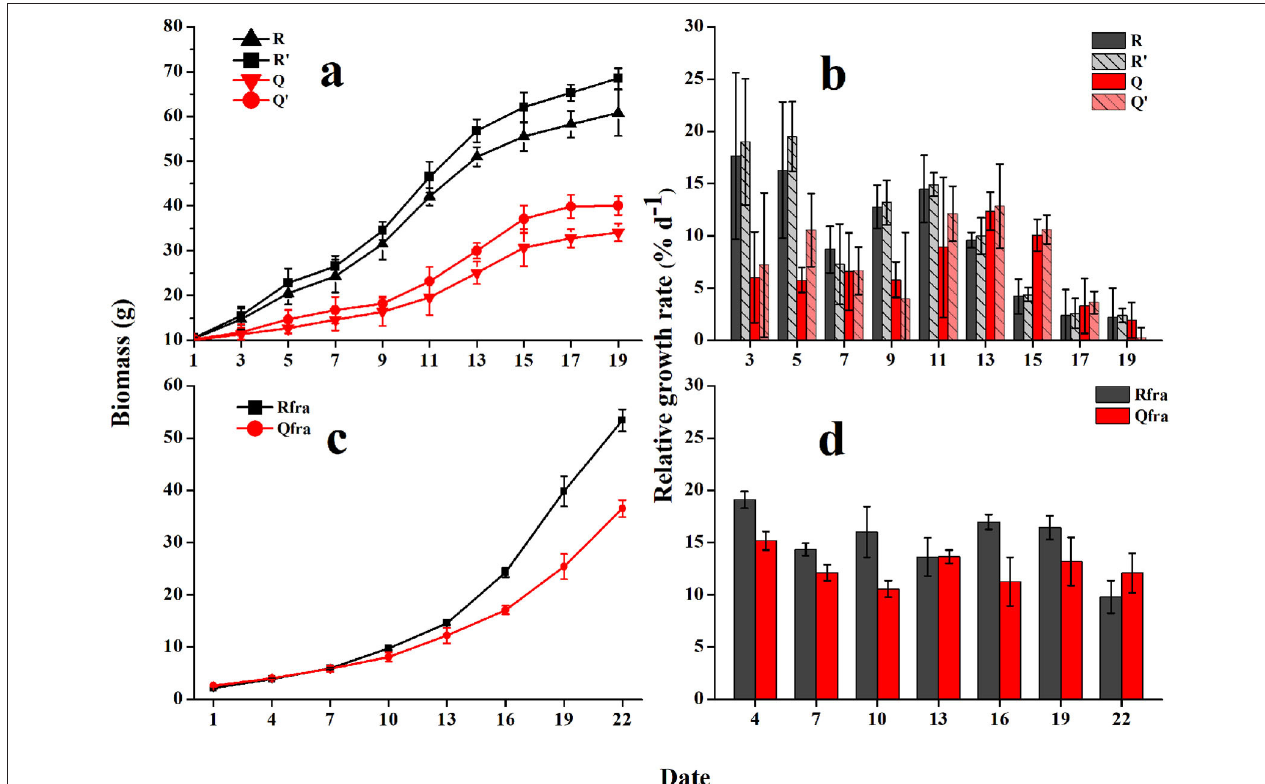
FIGURE 5 | The growing curves (a) and relative growth rates [RGRs, (b) ] of floating U. prolifera algae; and growth curves (c) , and RGRs (d) of fragments. Error bars are SE ( n = 3).